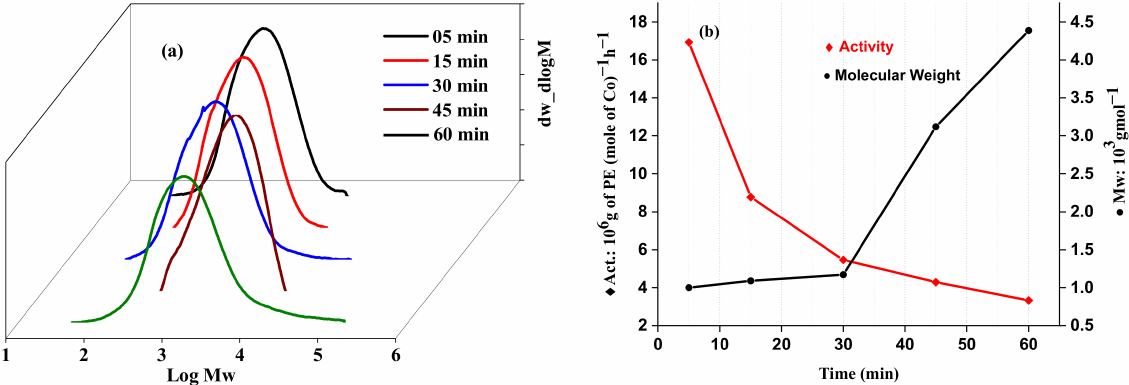
Figure 8. GPC curves of the obtained polyethylene ( a ); activity and M w as a function of reaction time ( b ) for the Co1 /MMAO system (Table 3, entries